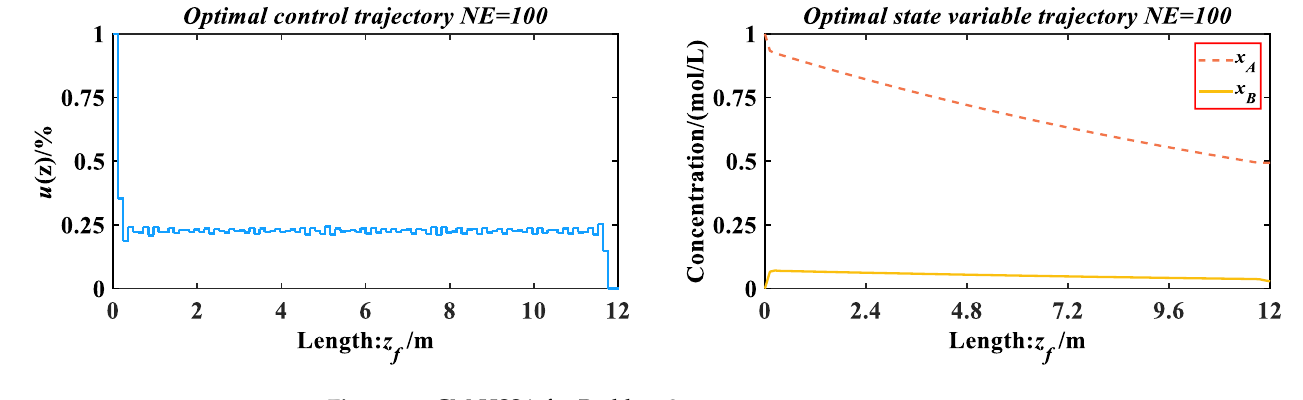
Figure 23. CM-HSSA for Problem 2. Table 7. Comparison of optimization results for Problem